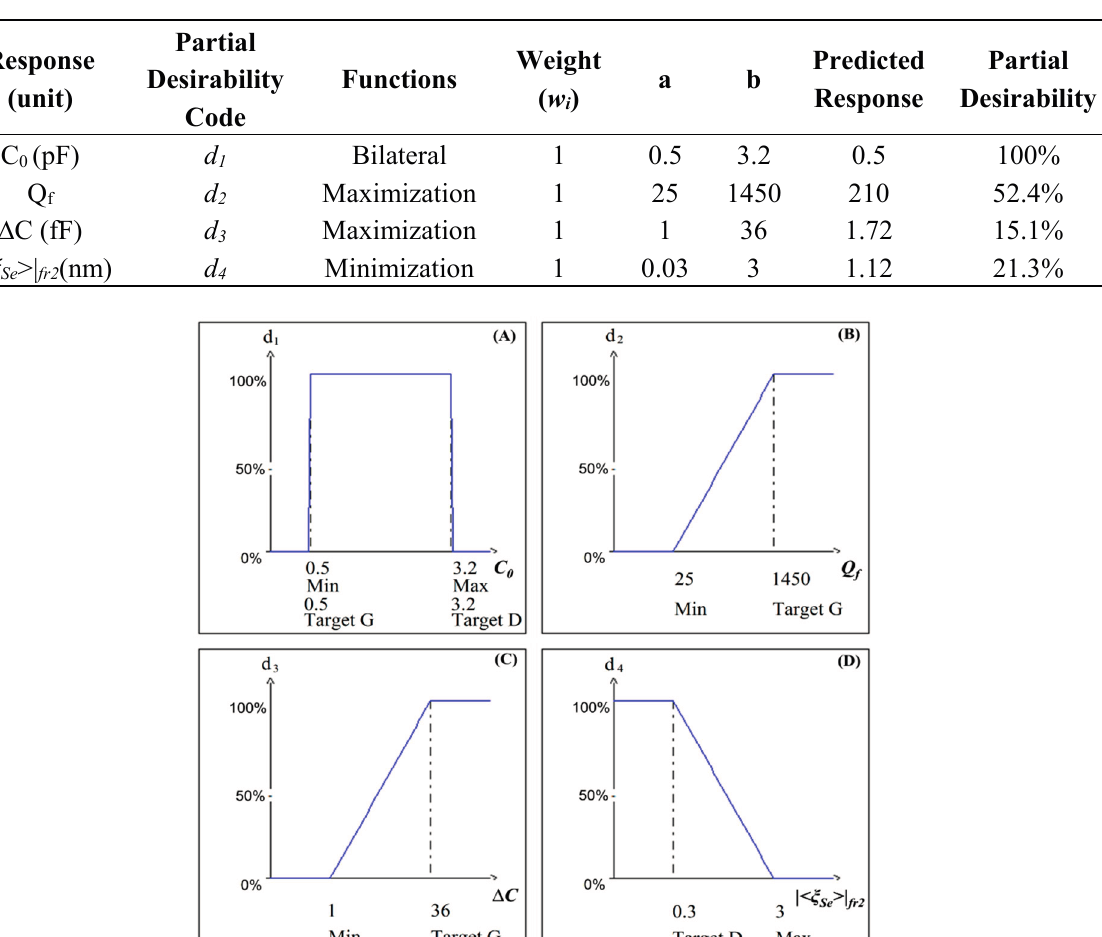
Table 6. Optimization criteria and desirability functions for the optimization of an acoustic resonant sensor.